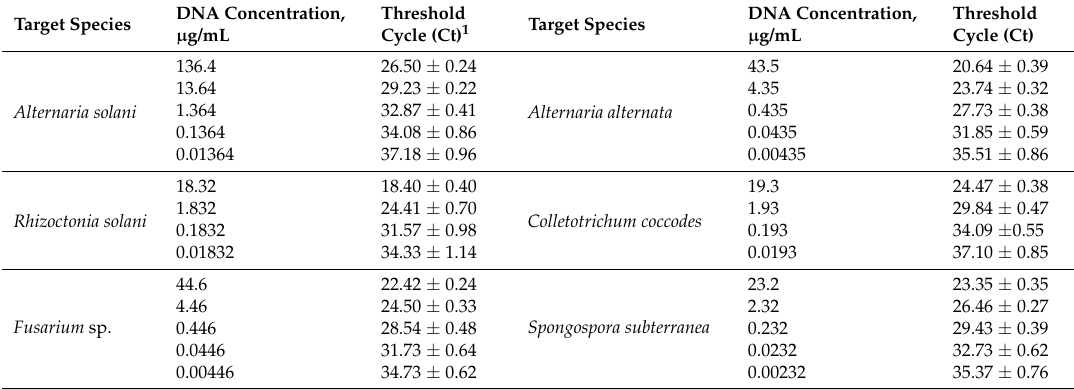
Table 7. Performance of lyophilized diagnostic systems for serial dilutions of DNA of target species. Target